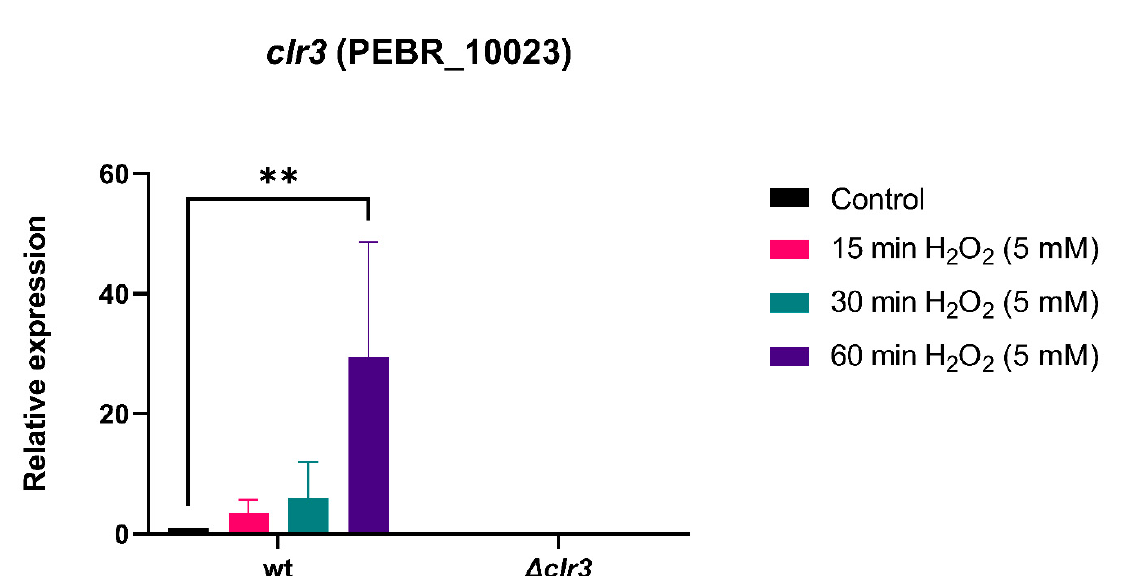
Figure 3. clr3 is induced during oxidative stress in the wild-type (wt) strain. Expression of clr3 was investigated by RT-qPCR in the strains subjected to oxidative stress caused by hydrogen peroxide during the indicated time points at 30 °C. Values represent the average of the results from three independent experiments with two technical repetitions The error bars represent standard deviation, ** p ≤ 0.01 (one-way ANOVA, significance level 0.05).